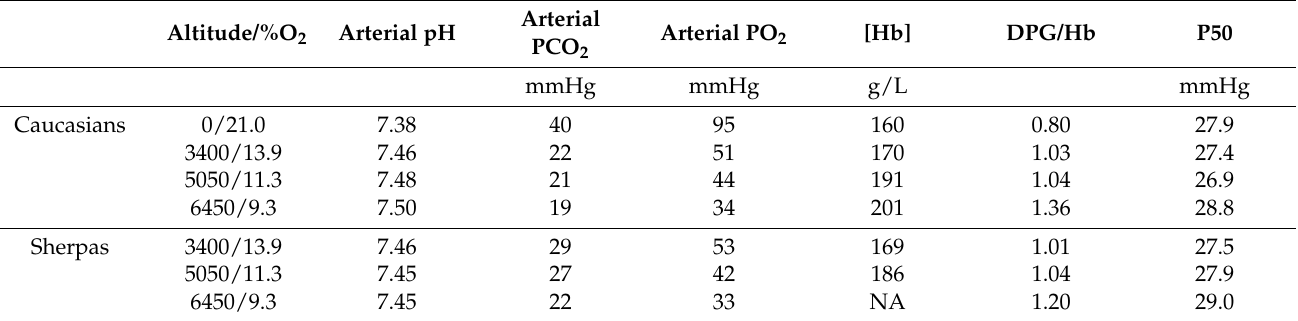
Table 2. Oxygen transport characteristics in Caucasians and Sherpas at varying altitudes. All data except P50 are from [212]. The P50 was calculated using the equations reported in [209] assuming carbon-monoxide-bound Hb = 0 and temperature = 37 ◦